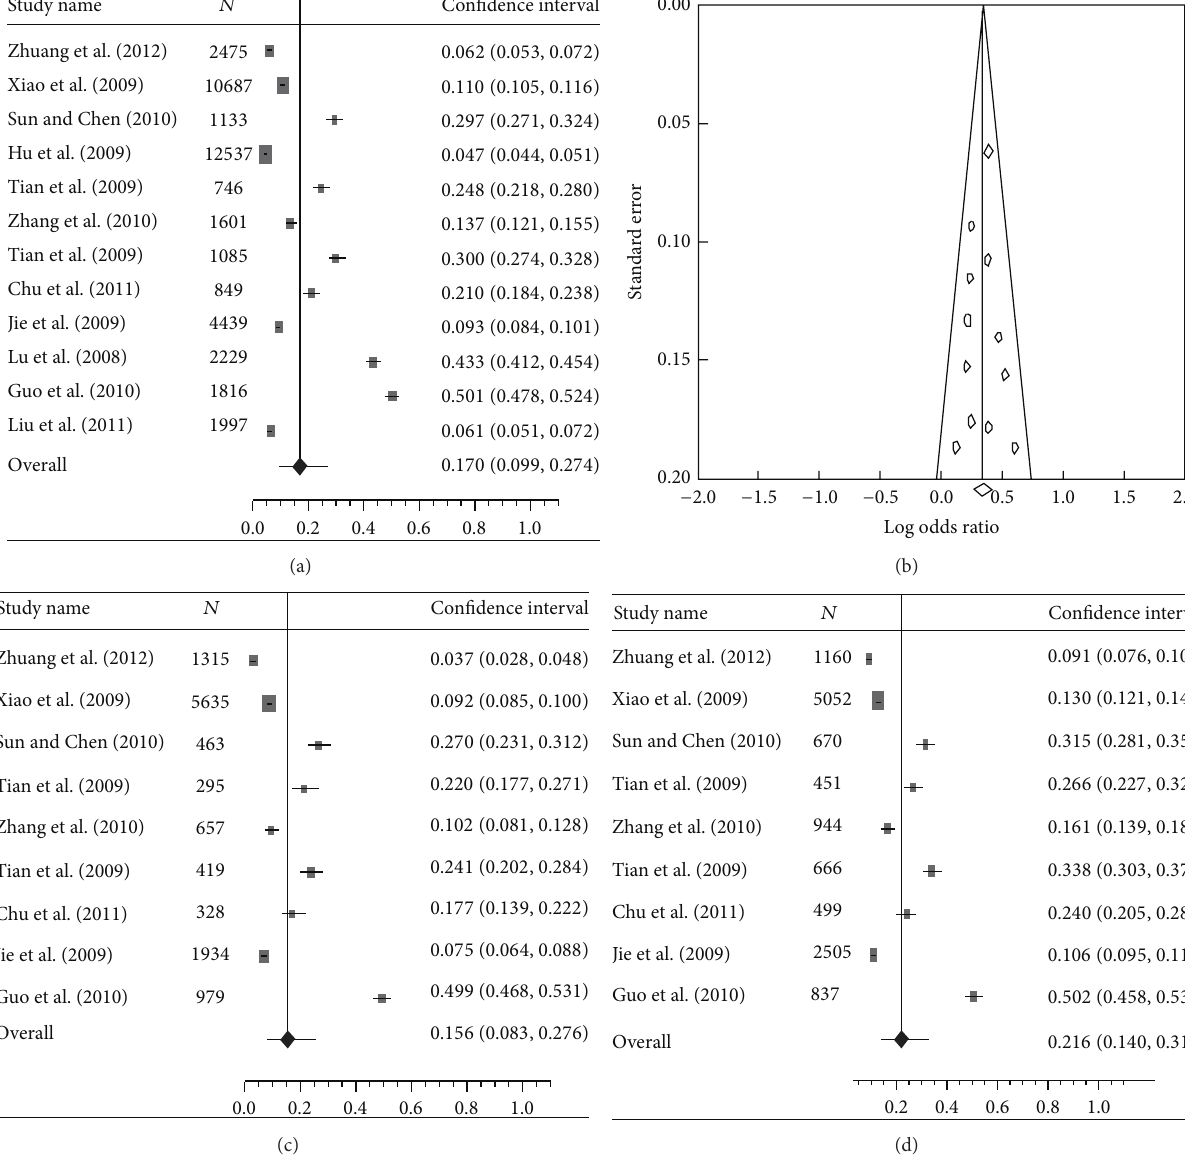
Figure 2: (a) A forest plot displaying the pooled prevalence of dry eye syndromes (DES) in the population of mainland China. (b) A funnel plot of studies conducted on the prevalence of DES in China. (c) A forest plot displaying the pooled prevalence of DES in the male gender in China. (d) A forest plot displaying the pooled prevalence of DES in the female gender in